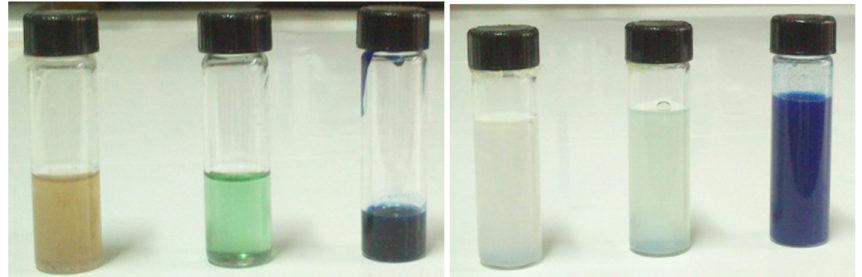
Figure 22. Left: liquid crystals of organometallic zinc, copper, and copper chloroacetate, respectively. Right: microemulsions of organometallic zinc, copper, and copper chloroacetate. Adapted from